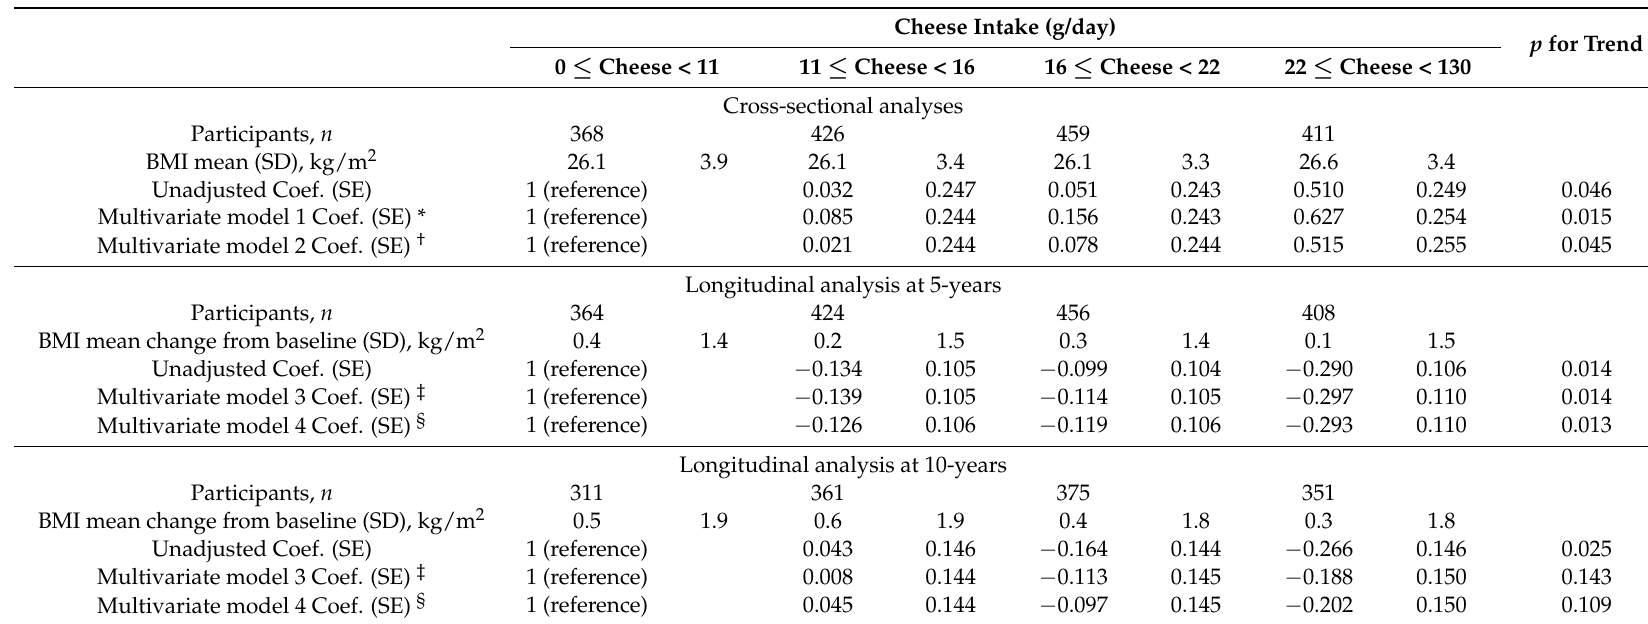
Table 4. Cross-sectional analysis of BMI at baseline and longitudinal analyses over 10-year of BMI changes from baseline by quartile of cheese intake. Cheese Intake (g/day) p for Trend 0 ≤ Cheese < 11 11 ≤ Cheese < 16 16 ≤ Cheese < 22 22 ≤ Cheese <